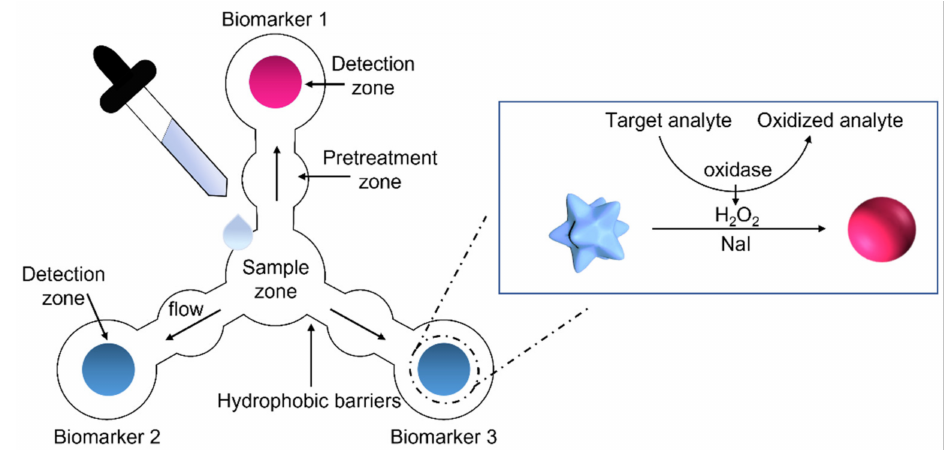
Figure 1. Schematic illustration of the monolithic paper-based device for the simultaneous detection of three salivary biomarkers. The device was realized using a CO 2 laser cutter. A drop of saliva is deposited in the central area (sample zone). Flowing in a microfluidic pattern, saliva passes through the pretreatment zones, where it is mixed with the deposited halogen (NaI), after which it reaches the detection zones, previously spotted with the blue colloidal suspension of MGNPs, functionalized with a layer of oxidase enzymes, one for each sensing area. The insert shows the colorimetric detection strategy that relies on the target-induced reshaping of plasmonic MGNPs, mediated by H 2 O 2 (byproduct of the biomarker oxidation by the specific oxidase enzyme), in presence of NaI. This reaction leads to a visible color change from blue to pink for non-physiological levels of the target